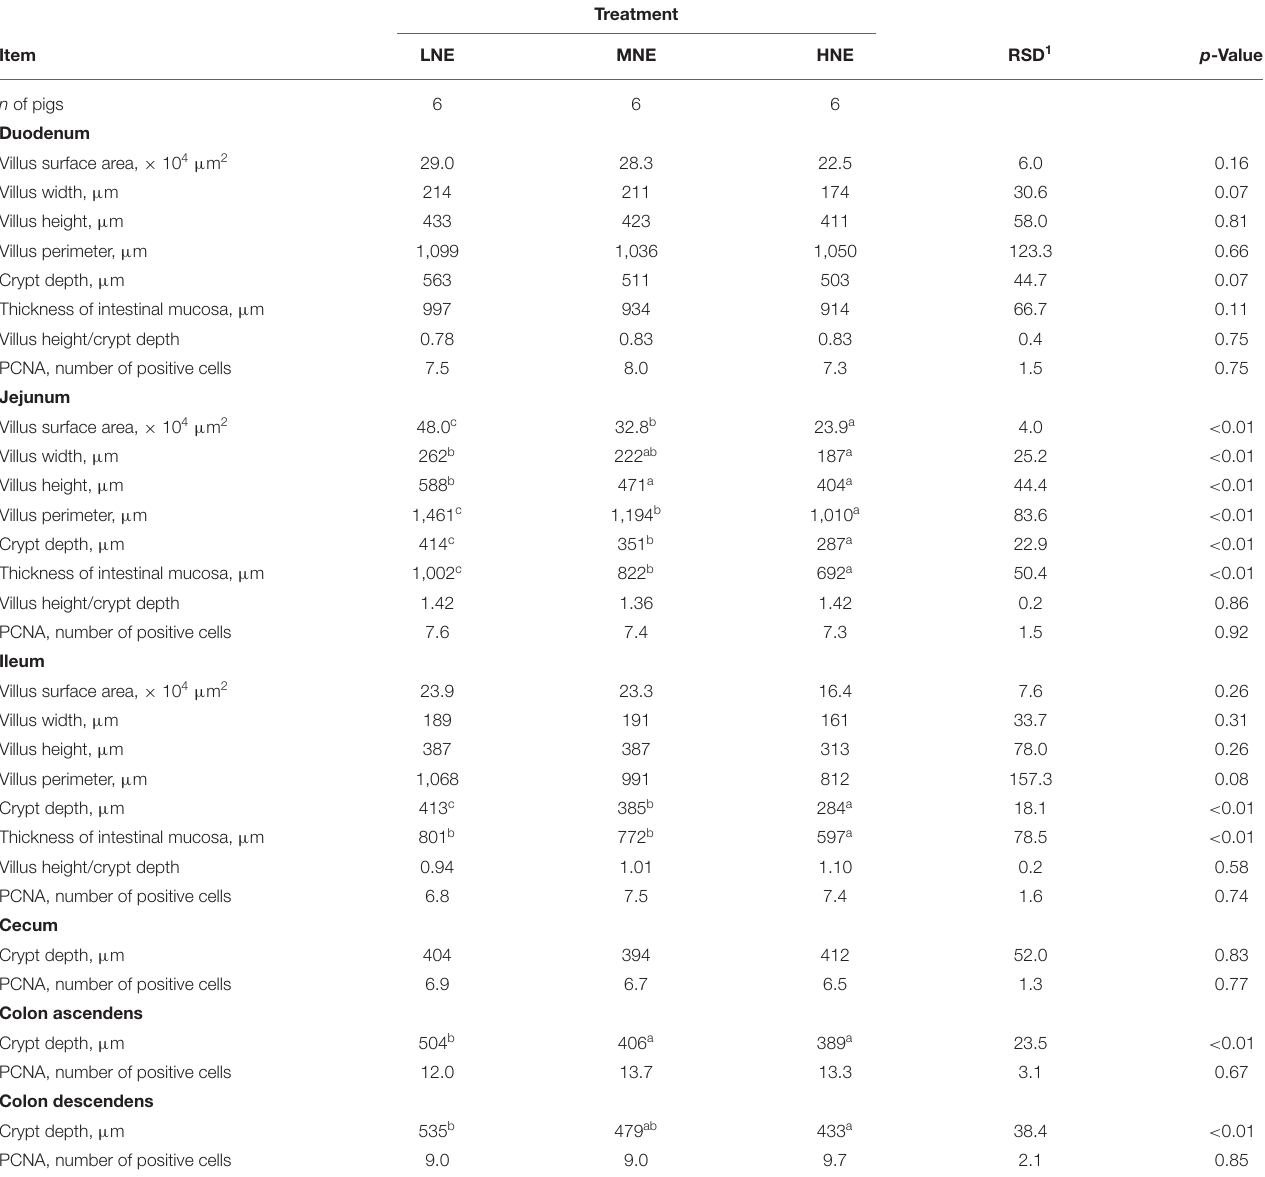
TABLE 5 | Effect of changes in dietary net energy concentration on intestinal morphology and mitotic cell count.